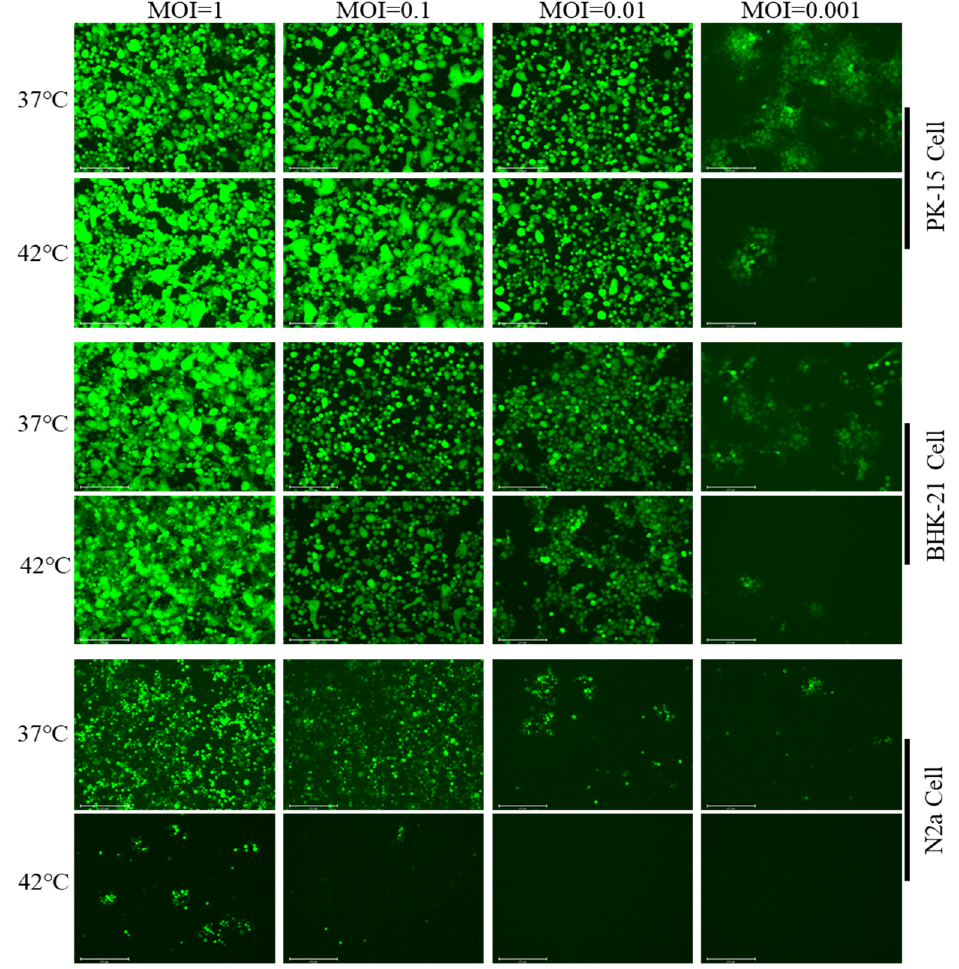
Figure 2. Screening for appropriate cell types and optimal infectious dose for in vitro PRV latent infection models. N2a, BHK-21, and PK-15 cells were seeded into 35 mm dishes at 5 × 10 5 per dish and were cultured with complete medium. rPRV-EGFP was added to the three cell types at an MOI of 1, 0.1, 0.01, or 0.001. The infected cells were incubated continuously at 37 or 42 ◦ C for 72 h. Fluorescence was monitored at 72 h